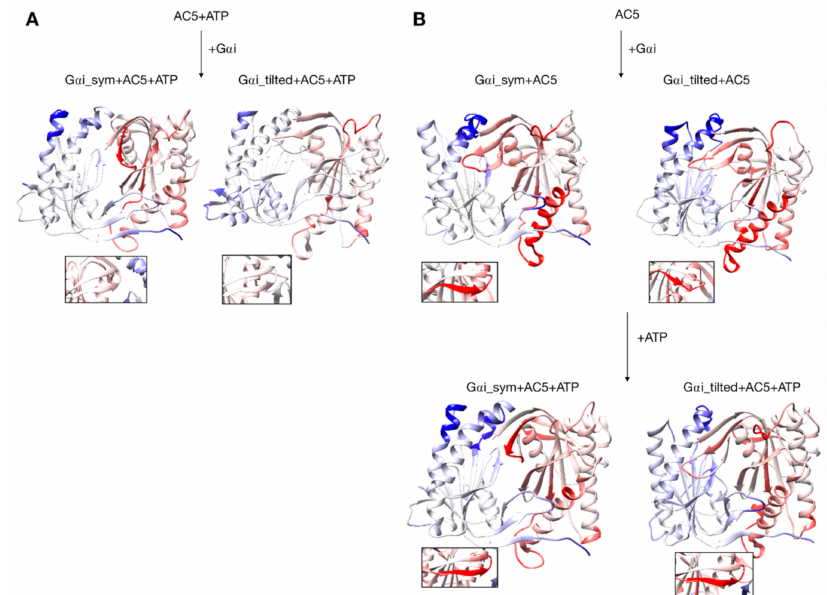
Figure 6. Changes in conformation induced by G α i protein. ( A ) scenario where ATP is already bound to AC5 when G α i interacts, ( B ) scenario where ATP is not yet bound to AC5 when G α i interacts. More intense colors (blue for domain C1 and red for domain C2) correspond to larger movements compared to the preceding structure (i.e., AC5 + ATP for A and AC5 and AC5 + G α i for B) on a scale of 0 to 4 Å. The insets display the β 4 loop.